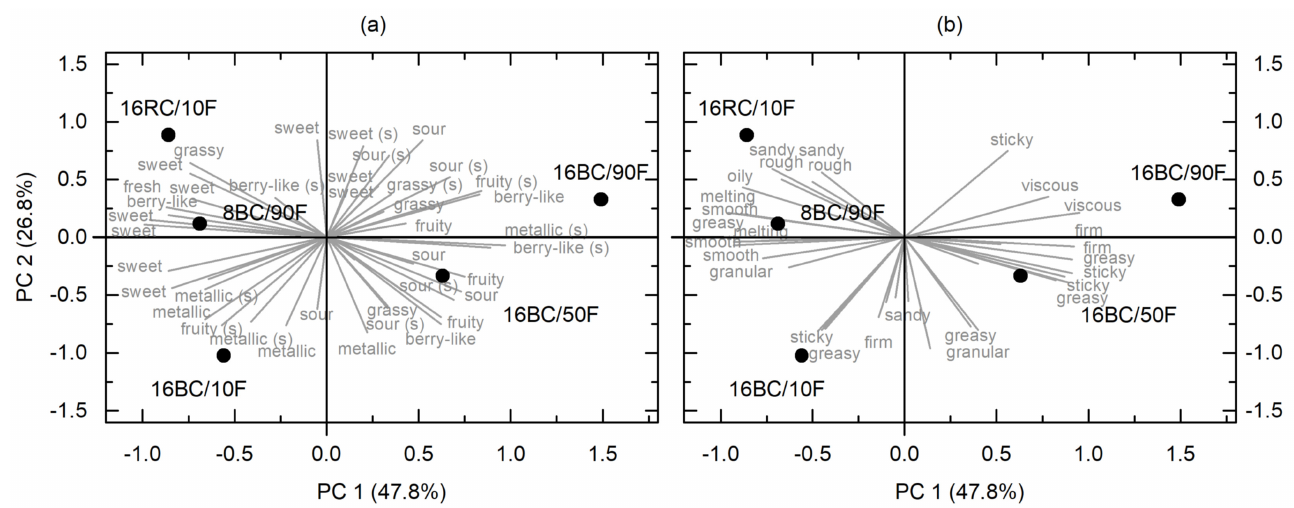
Figure 5. Biplots describing sensory differences between sweet spreads containing currant pomace: ( a ) Loadings with flavor attributes ((s) refers to smell); ( b ) Loadings with texture/mouthfeel attributes. Spread coding refers to pomace content (g/100 g), pomace variety (BC—blackcurrant; RC—redcurrant), and the ratio of palm fat (F) related to total fat (%). Only loadings, which were mentioned repeatedly, are labeled.